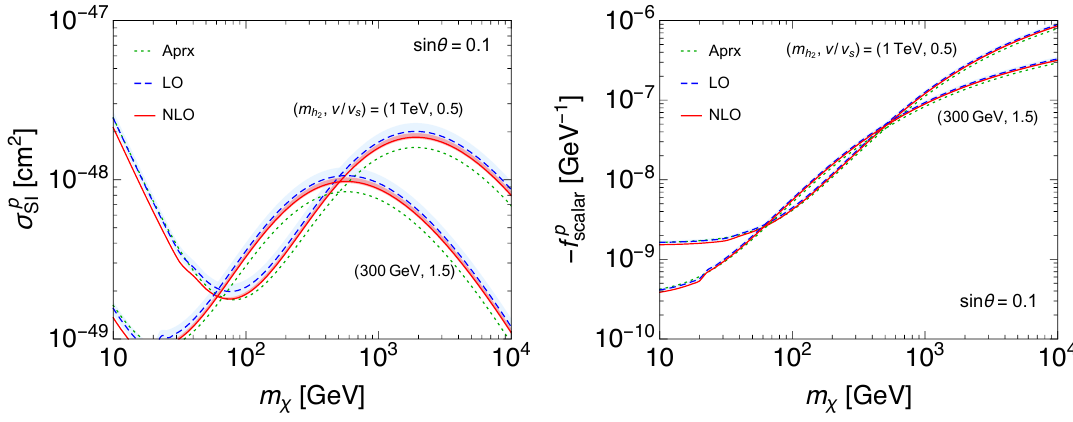
Figure 2 . (Left) Spin-independent cross section of DM with proton for two sample parameter points, ( m h ; v=v s ) = (300 GeV ; 1 : 5) and (1 TeV ; 0 : 5), for sin (cid:18) = 0 : 1. The numerical evaluations 2 with the approximate expression eq. (3.15), LO and NLO in QCD are shown as ‘Aprx’ (green dotted), ‘LO’ (blue dashed), and ‘NLO’ (red solid). For LO and NLO results, the perturbative errors are also shown in shaded region. (Right) (Minus) scalar-type e(cid:11)ective coupling f p same sample parameter points. The line legends are the same as left